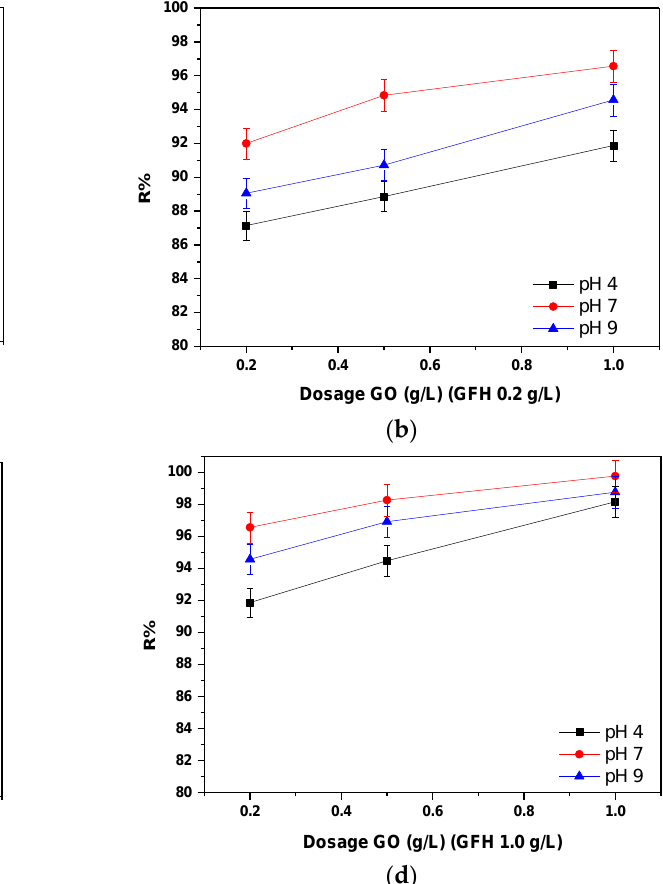
Figure 2. Effect of GO dosage on As(III) % removal with combined addition of several doses of GFH ( a ) 0.1 g/L, ( b ) 0.2 g/L, ( c ) 0.5 g/L, ( d ) 1.0 g/L; initial As(III) concentration 100 μg/L, pH 4.0, 6.0, 7.0 ± 0.1, T = 298 K, contact time 24 h, in deionized water.